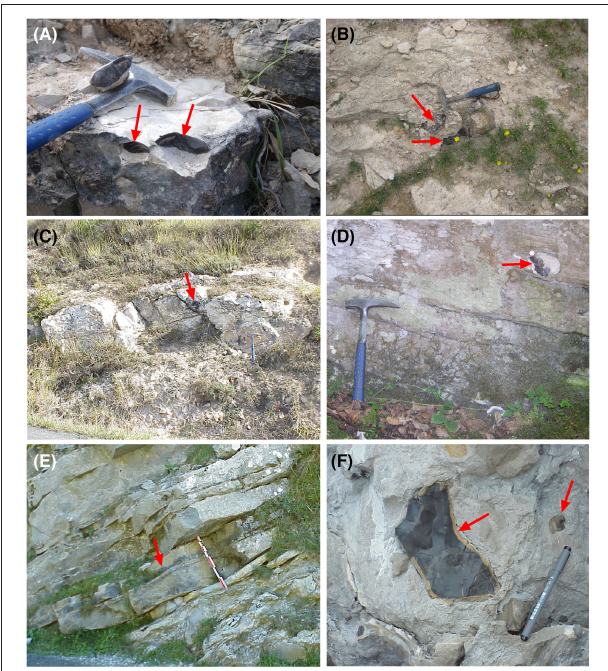
FIGURE 3 | Field examples of the different chert types studied in this work. (A) Treviño; (B) Ablitas; (C) Loza; (D) Urbasa; (E) Artxilondo; (F) Kurtzia. Red arrows indicate the positions of chert nodules or accumulations. Note the nodular appearance of chert in all cases but in (E) , where laminar chert is